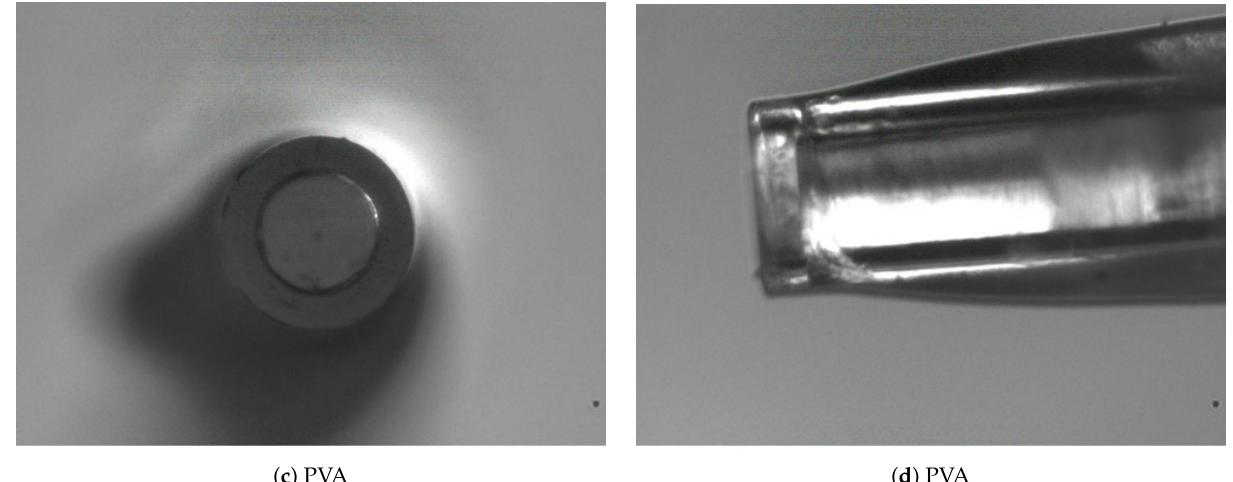
Figure 7. ( a ) Silica diaphragm axial view; ( b ) Silica diaphragm side view; ( c ) PVA diaphragm axial view; ( d ) PVA diaphragm side view.